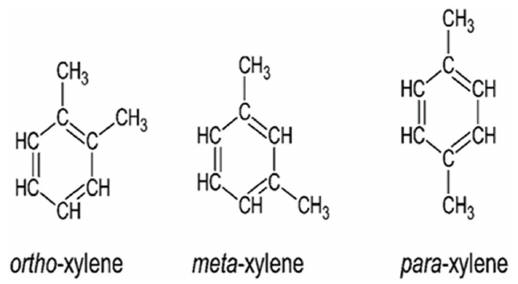
Figure 1. Xylene